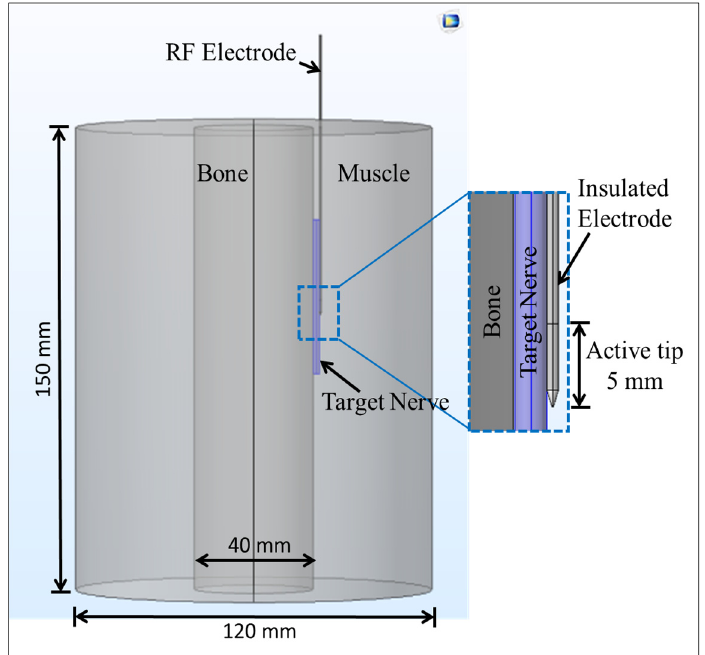
Figure 1. Schematic of three-dimensional computational domain comprising of nerve, bone and muscle tissues with an inserted monopolar radiofrequency (RF) electrode.